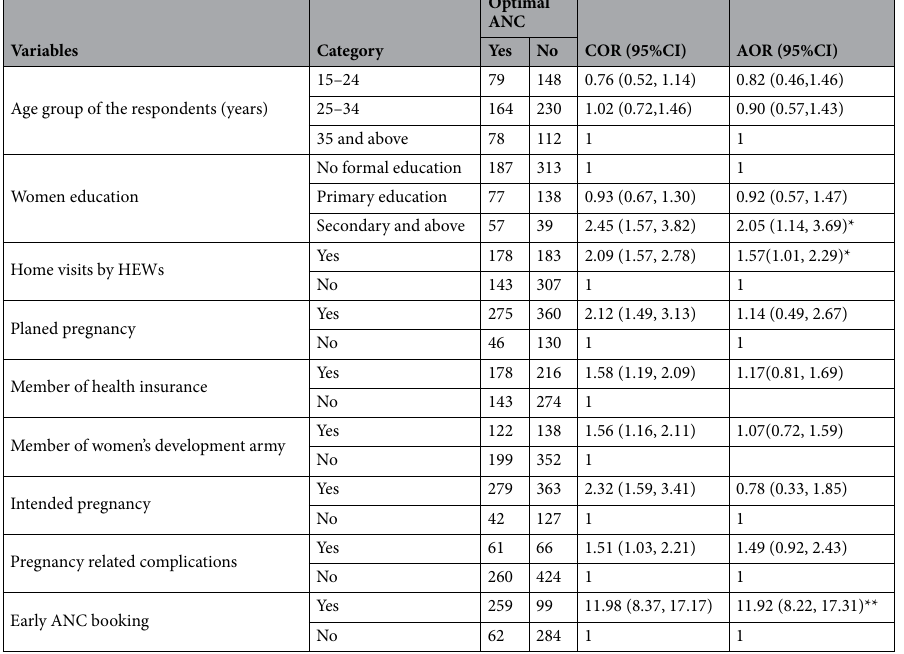
Table 4. Factors affecting optimal antenatal care in a rural Northwest Ethiopia, 2020. *Significant at p < 0.05. **Significant at p <